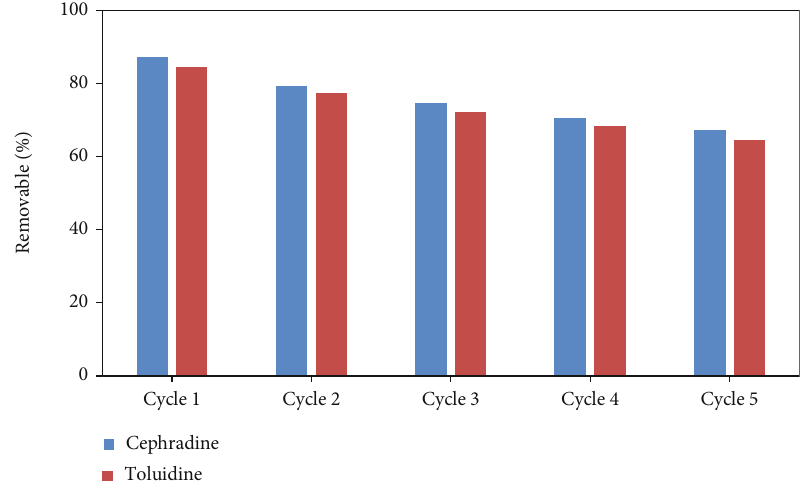
Figure 13: Reusability and regeneration of polymeric hydrogel (GA/AM) toward safranin and toluidine